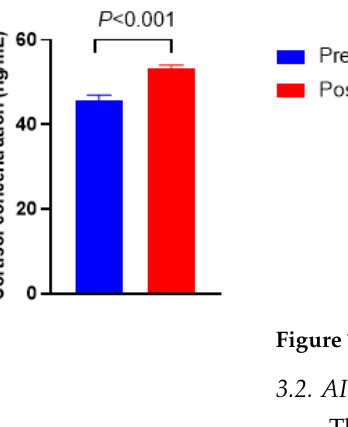
Figure 2. AI-2 concentration and luxS gene expression before (Pre) and after (Post) diet shift. 3.3. Microbial Density, Biofilm Formation, ftsH Gene Expression, and Extracellular Polymeric Substances Composition Figure 3 shows the microbial density, biofilm formation, and ftsH gene expression. The microbial density and biofilm formation were higher in Post than in Pre ( p = 0.012 and p = 0.013, respectively). The expression of the ftsH gene in Post was 3.5-fold higher than in Pre ( p = 0.009). No significant differences were observed in the exopolysaccharide and protein concentrations of extracellular polymeric substances (Figure 4, p > 0.10). Figure 3. Microbial density, biofilm formation, and its related gene expression before (Pre) and after (Post) diet shift.